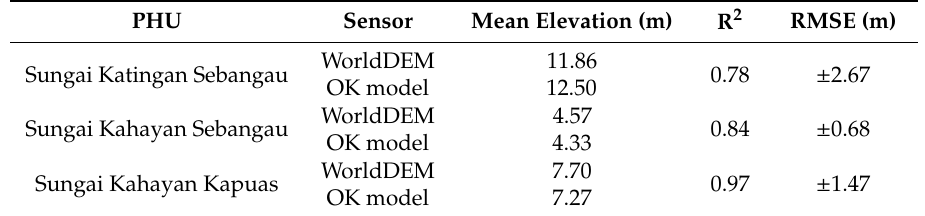
PHU Sensor Mean Elevation (m) R 2 RMSE (m) WorldDEM